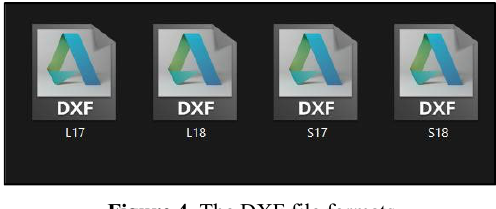
Figure 4. The DXF file formats